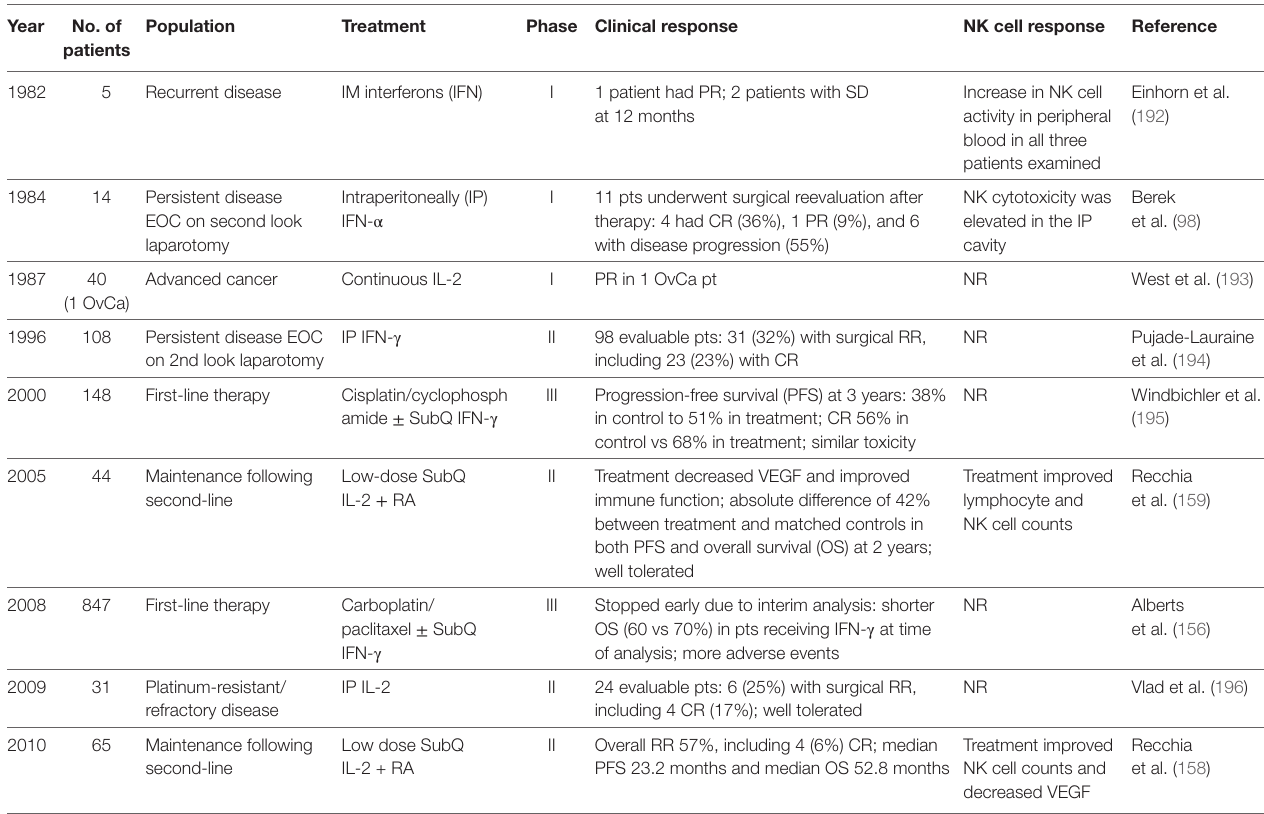
TABLe 1 | Natural killer (NK) cell findings from clinical trials of cytokine immunotherapy for ovarian cancer.